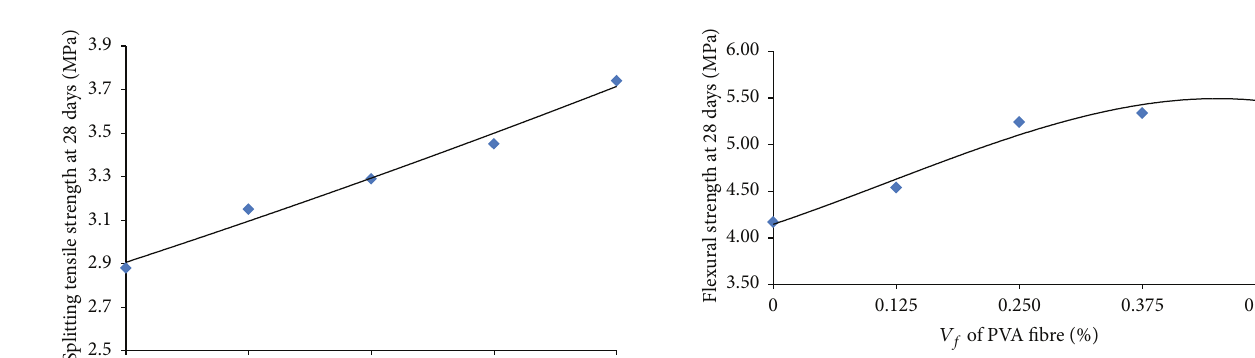
Figure 12: Relationship between PVA fiber volume fraction and flexural